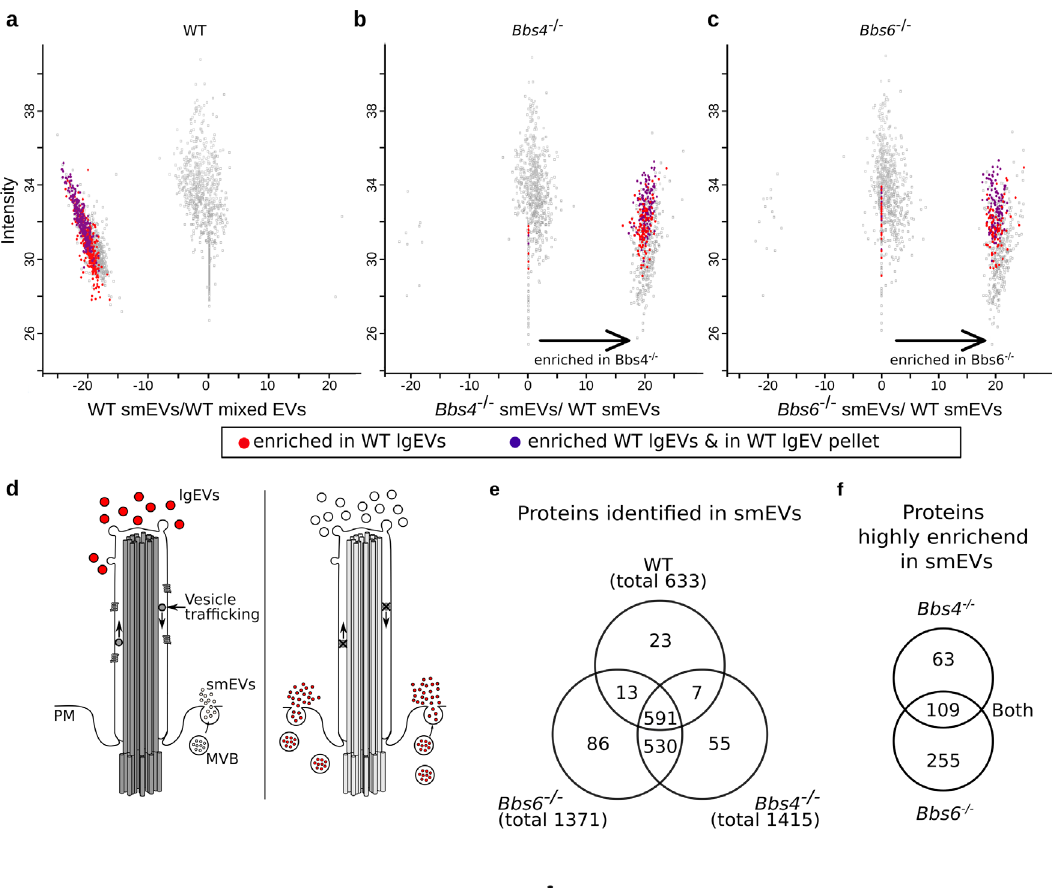
Fig. 3 Cilia dysfunction alters EV protein composition. a – c Proteins identi fi ed via liquid chromatography-mass spectrometry analysis in four out of six pellets isolated from control and ciliated mutant KM cell supernatant. Source data are provided as a Supplementary data fi le. a Repeat of scatter plot in Fig. 2c depicted to demonstrate change in the mode of protein release from lgEVs in control to smEVs upon cilia dysfunction for the subset of proteins. b , c Proteins identi fi ed in smEV preparations from control vs. cilia mutant cells. Proteins in the right cluster were enriched in smEVs released from mutant cells. Proteins demarked in red and purple were proteins considered enriched in control lgEVs and absent from control smEVs. Their shift to the right cluster suggests an altered method of release from mutant cells. d Simpli fi ed schematic representation of possible modes of EV release. lgEVs are released at the ciliary tip and smEVs from the cell membrane. Upon ciliary dysfunction, this is hampered and increased MVB-derived smEVs are released directly from the cell membrane ( fi gure created by V.Kretschmer). e Absolute numbers of different protein populations depicted in ( b , c ). Bbs4 − / − and Bbs6 − / − smEVs contained twice as many proteins compared to control. f Number of proteins signi fi cantly enriched ( P value − log ≥ 2) in Bbs4 − / − and Bbs6 − / − smEVs compared to the control. Table 2 Gene ontology enrichment analysis (getgo.russelllab.org) of proteins highly enriched in ciliary mutant smEVs. EV sample Term Signalling pathway